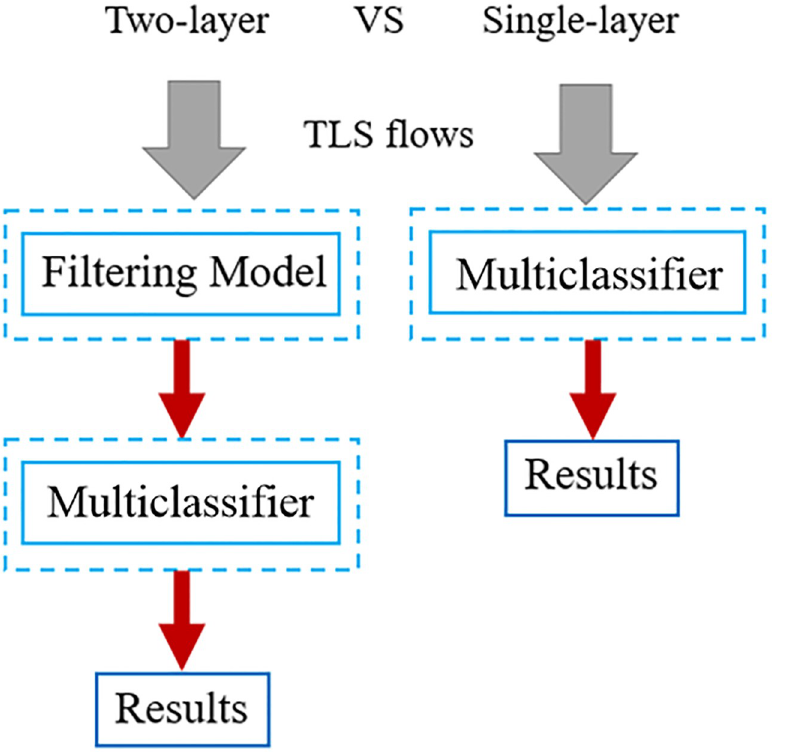
Fig 8. The processing flow of the two